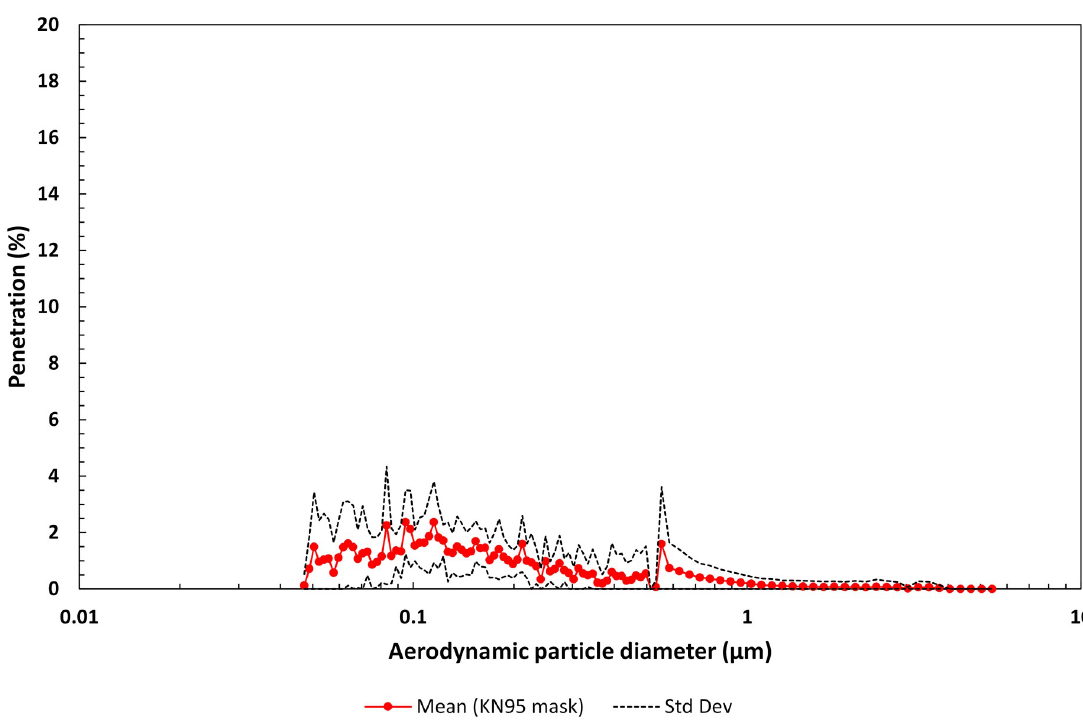
Fig 7. Mean penetration profile as a function of aerodynamic particle diameter for the filter material of two KN95 masks (five replicates each). Note, the penetration range is 0 to 20%.